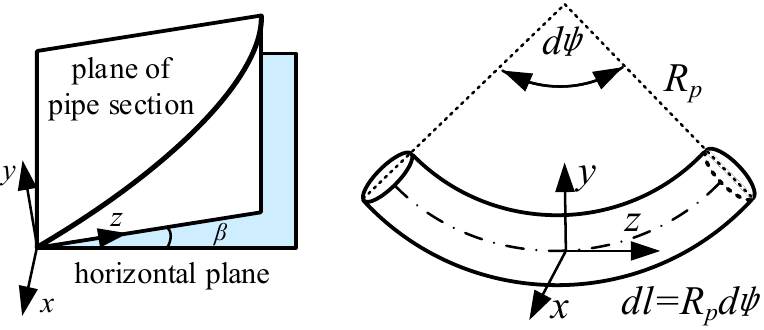
Figure 1. Schematic of the pipe section conveying fluid.